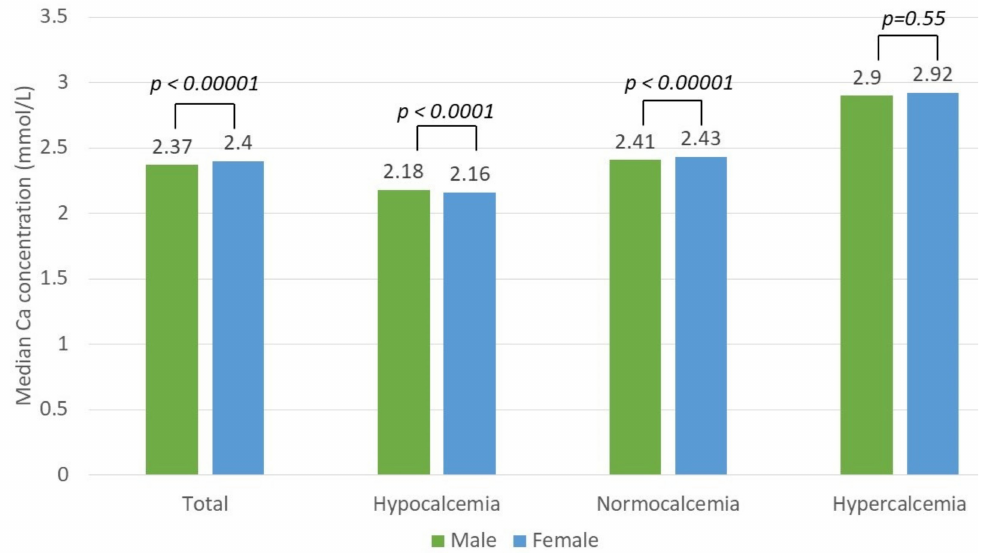
Figure 2. Difference in the median calcium (Ca) concentration between sexes in the total patient and hypo-, normo-, and hypercalcemia groups.